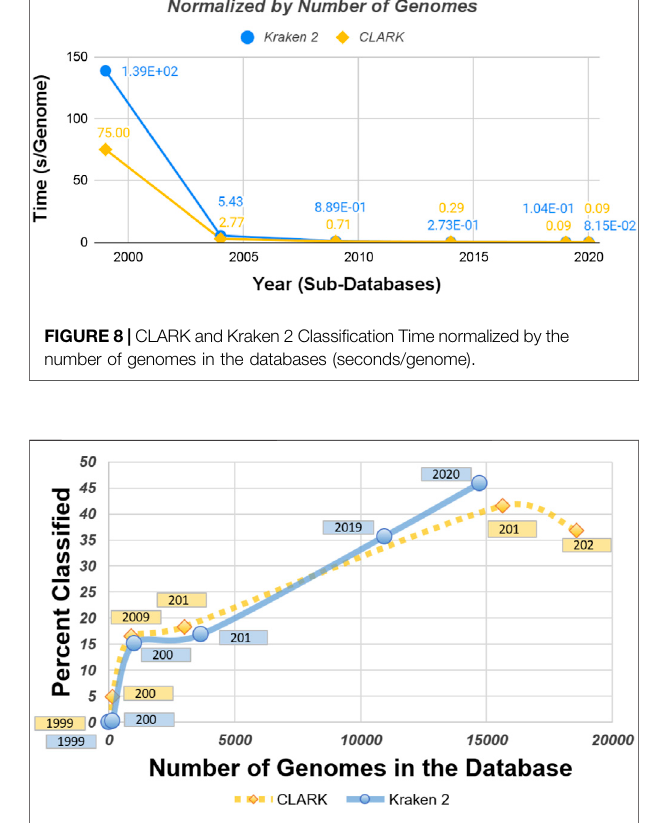
FIGURE 9 | Graph comparing the number of genomes in their databases with the percent classi fi ed for each sub-database for CLARK and Kraken